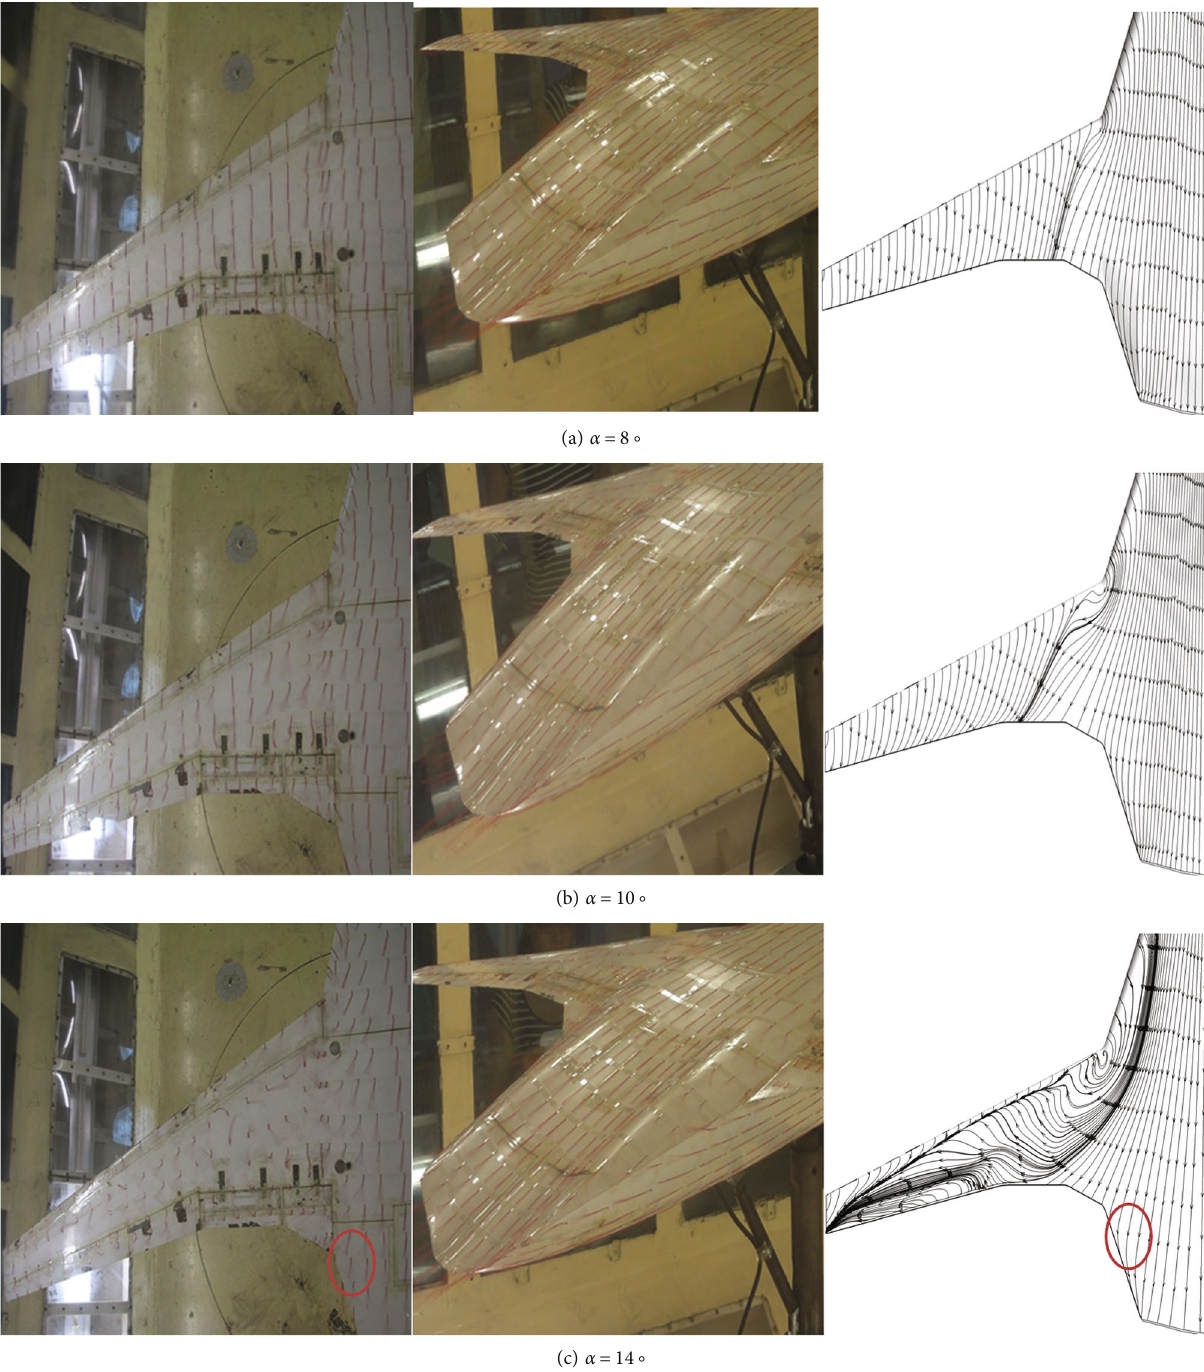
Figure 8: Surface steam lines of SWB wind tunnel test and CFD results at take-o ff